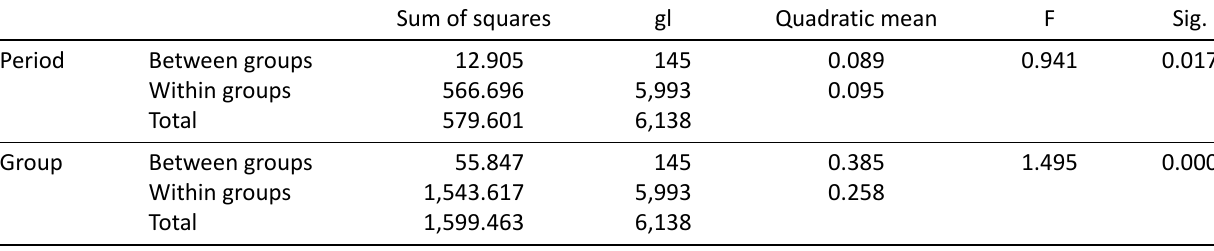
Table 6. Statistics of the analysis of the averages of the variances for RQ3. Sum of squares gl F